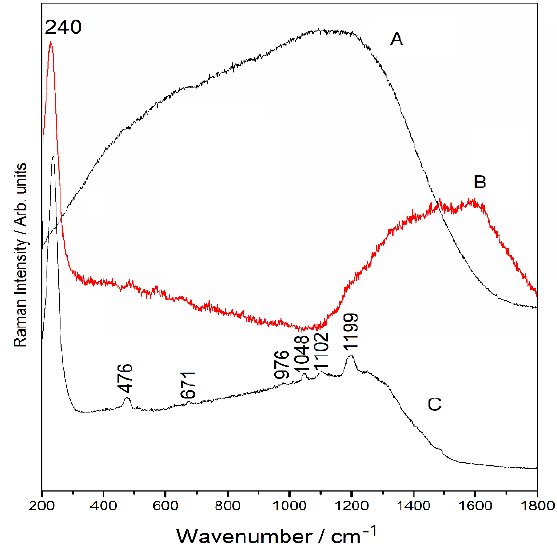
Figure 3. Raman and SERS Spectra of NBR soil sample and system 2,4-D/soil. A, Raman spectrum of NBR soil sample; B, SERS spectra of NBR soil sample; C, SERS spectra of 2,4-D/soil. The same methodology was used to obtain B and C spectra. Laser line 785 was used to record spectrum A and laser line 633 for spectra B and C.